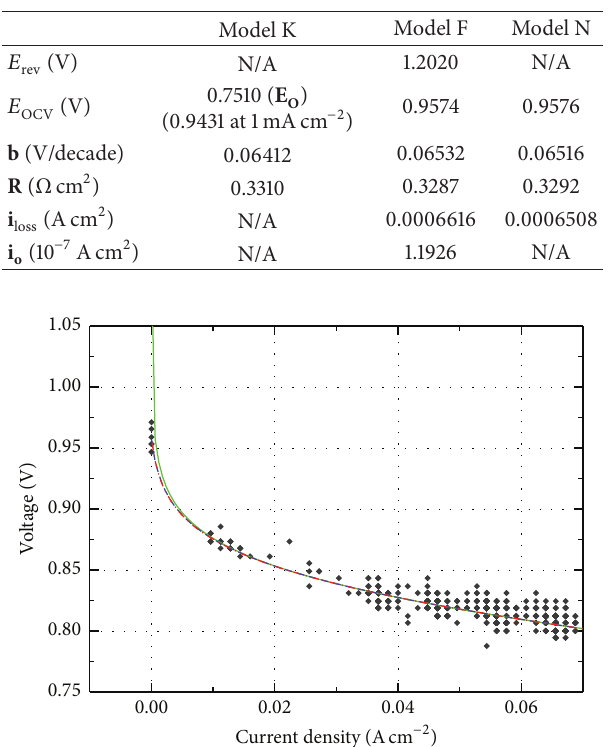
Table 6: Values of fitting parameters obtained from three models (road test).